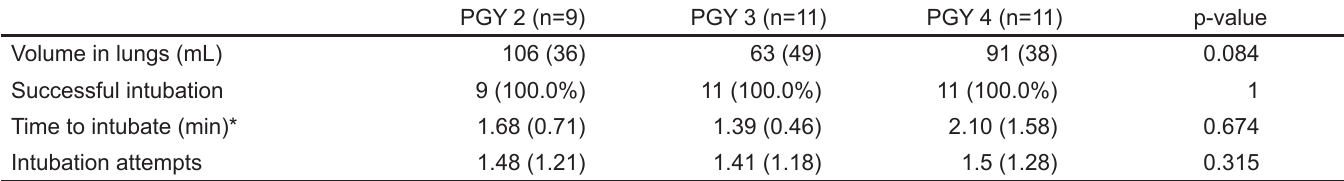
Table 3. PGY Subgroup Analysis of Primary and Secondary Outcomes.